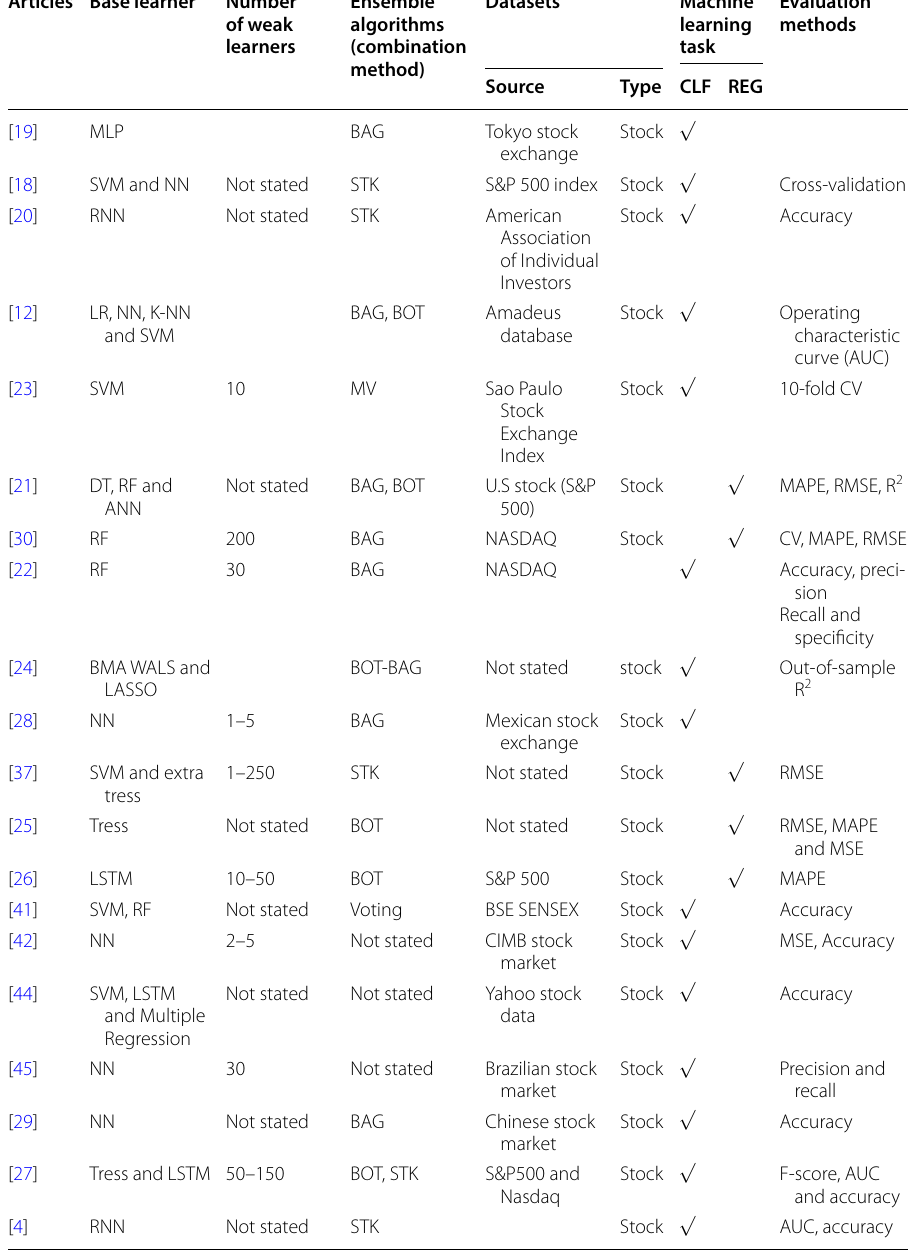
CV cross‑validation, RNN recurrent neural networks, CLF classification, MV majority voting, REG regression, MAPE mean absolute percentage error, MLP multi‑layer perceptron, RMSE root mean square error